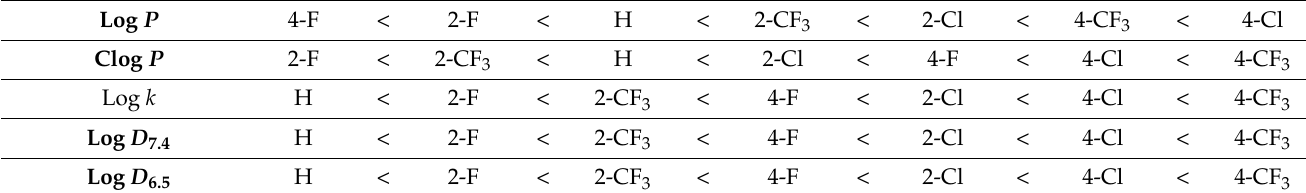
Figure 3. Comparison of experimentally found log k values with log D 7.4 ( A ) and log D 6.5 ( B ) values and log D 7.4 with log D 6.5 ( C ) of discussed compounds 1 – 7 . The order of lipophilicity of individual derivatives 1 – 7 is shown in Table 2. It can be seen that unsubstituted compound 1 has the lowest lipophilicity, and the ortho -substituted derivatives 2 , 4 , and the lipophilicity of compound 6 are lower than that of para -substituted compounds 3 , 5 , and 7 . The unexpected fact that derivative 6 (R = 2-CF 3 ) is less lipophilic than compound 4 (R = 2-Cl) is very interesting, while for para -substituted derivatives 5 and 7 , the order is exactly opposite; this order is logical and expected. Table 2. Discussed compounds ordered according to increasing lipophilicity values of individual derivatives.